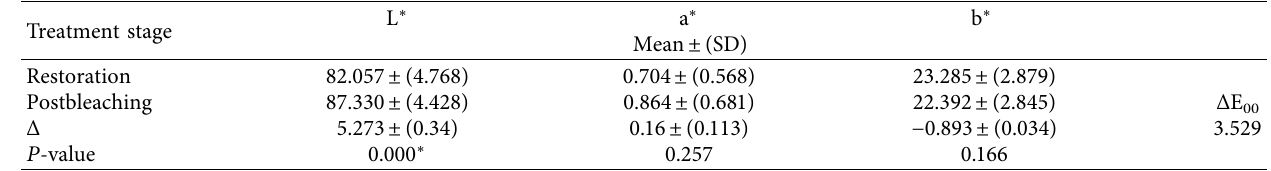
Table 4: Color difference in L ∗ , a ∗ , and b ∗ at after bleaching and 2 weeks after bleaching measurements. Treatment stage Postbleaching